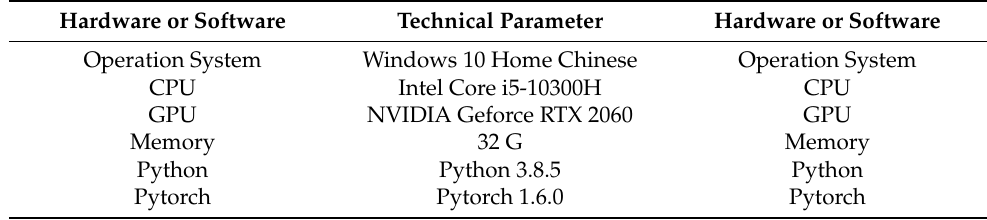
Table 1. Configuration of hardware and software.